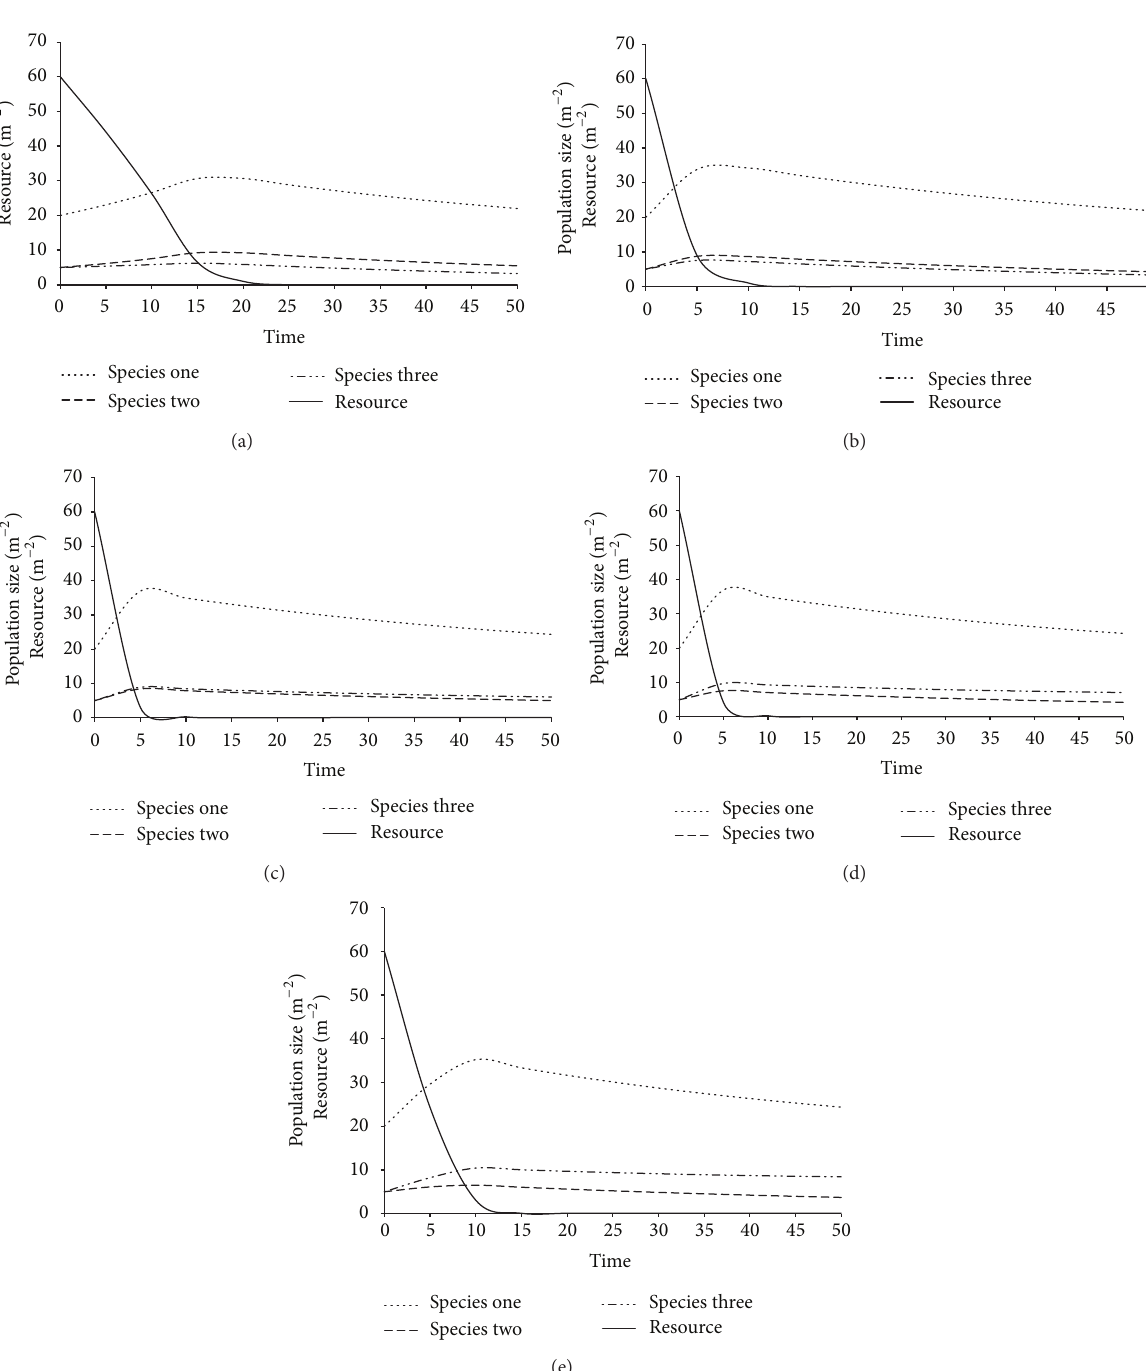
Figure 7: Behavior of the isoclines when initial, population size of species one is greater than species two and three; curves (a)–(e) show the behavior of population size for each species and resource at temperatures 10 ∘ C, 15 ∘ C, 20 ∘ C, 25 ∘ C, and 30 ∘ C,